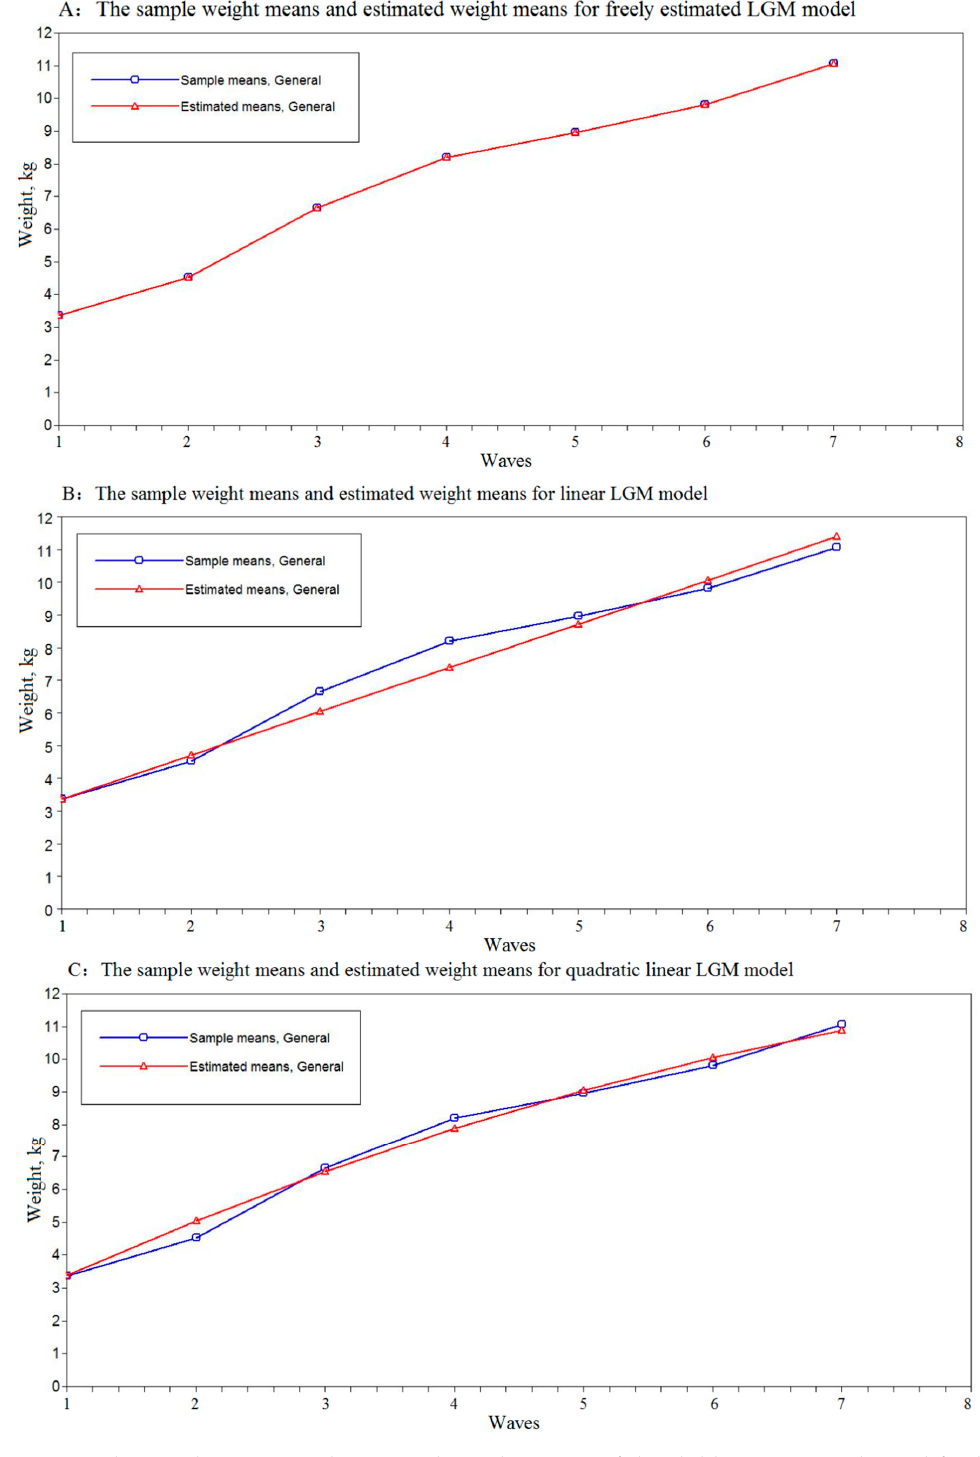
Figure 1. The weight means and estimated weight means of the children in unconditional freely estimated, linear, quadratic latent growth curve models. The child weight appears on the vertical axis (y) and the horizontal axis (x) represents the seven-time points; the axes should be continuous, not broken. The blue line represents the sample means and the red line represents the estimated means of the LGCMs. Panel ( A ) displays weight means and estimated weight means of the children in the unconditional freely estimated LGCM. Panel ( B ) displays weight means and estimated weight means of the children in the unconditional linear LGCM. Panel ( C ) displays weight means and estimated weight means of the children in the unconditional quadratic